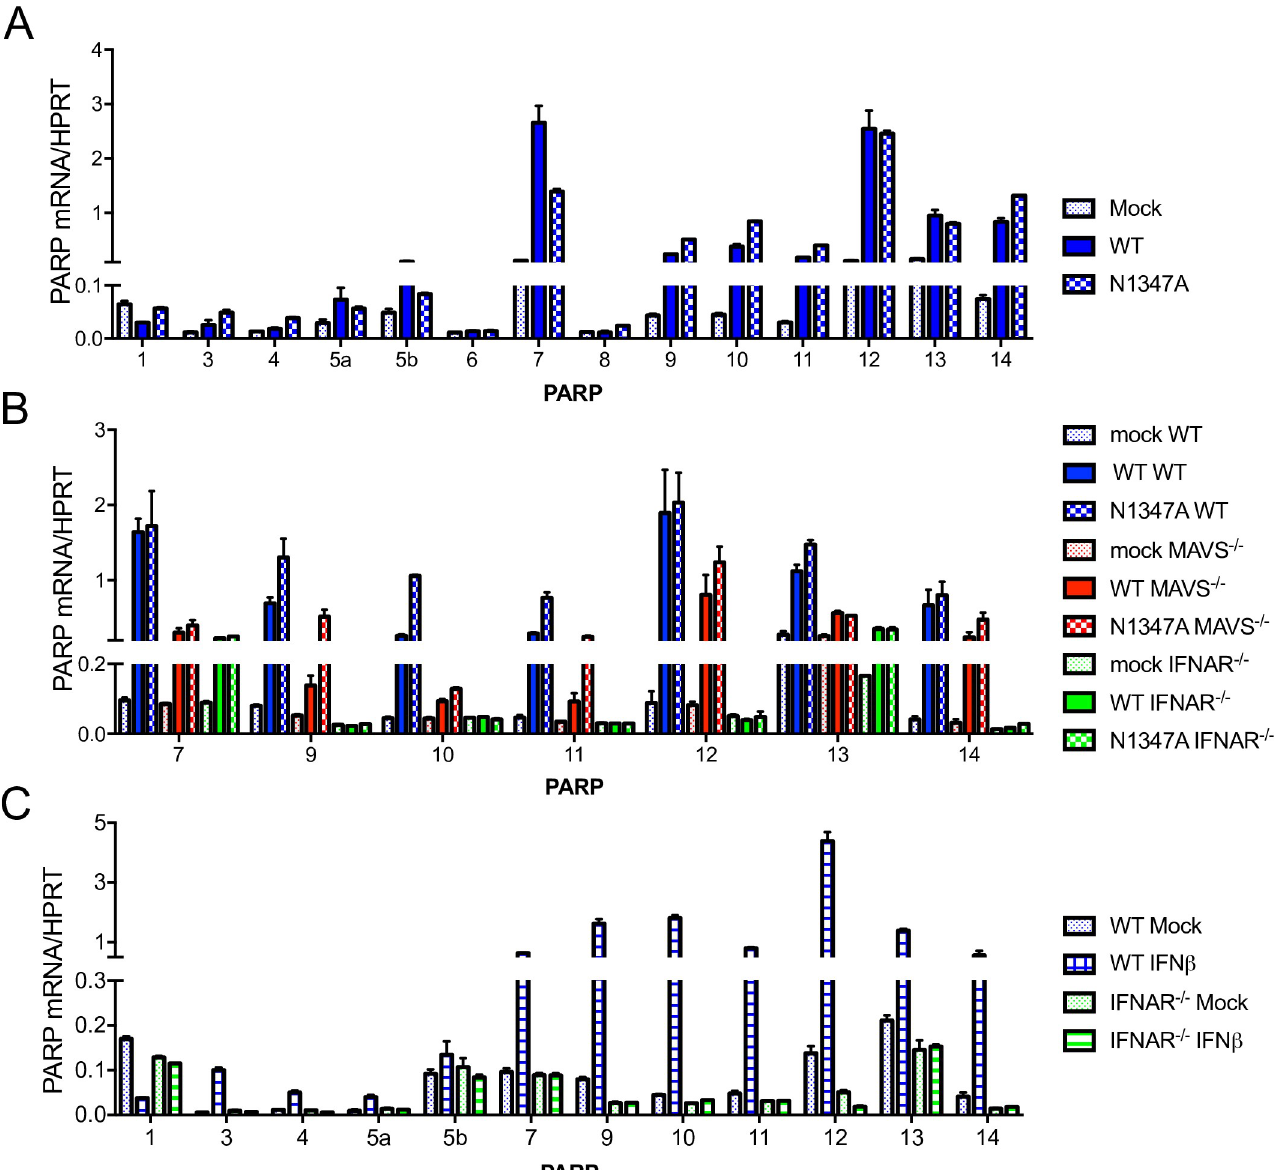
Fig 3. Several PARPs are highly upregulated by MHV infection and IFN treatment in BMDMs. (A) BMDMs were infected with WT or N1347A MHV and collected at 18 hpi. PARP expression was determined by RT-qPCR using primers listed in S3 Table and normalized to HPRT. PARP2 and PARP16 were undetectable and are not shown. (B) BMDMs isolated from WT, MAVS -/- , or IFNAR -/- mice were infected with WT or N1347A virus. Cells were collected at 18 hpi, and RNA levels of selected PARPs were determined by RT-qPCR and normalized to HPRT mRNA levels. (C) BMDMs from WT or IFNAR -/- mice were mock treated or treated with 1000 U IFN β for 8 h, and RNA levels were determined by RT-qPCR and normalized to HPRT. PARPs 6 and 8 fell below the limit of detection and are not shown. The data in (A-C) show one experiment representative of two independent experiments; n =